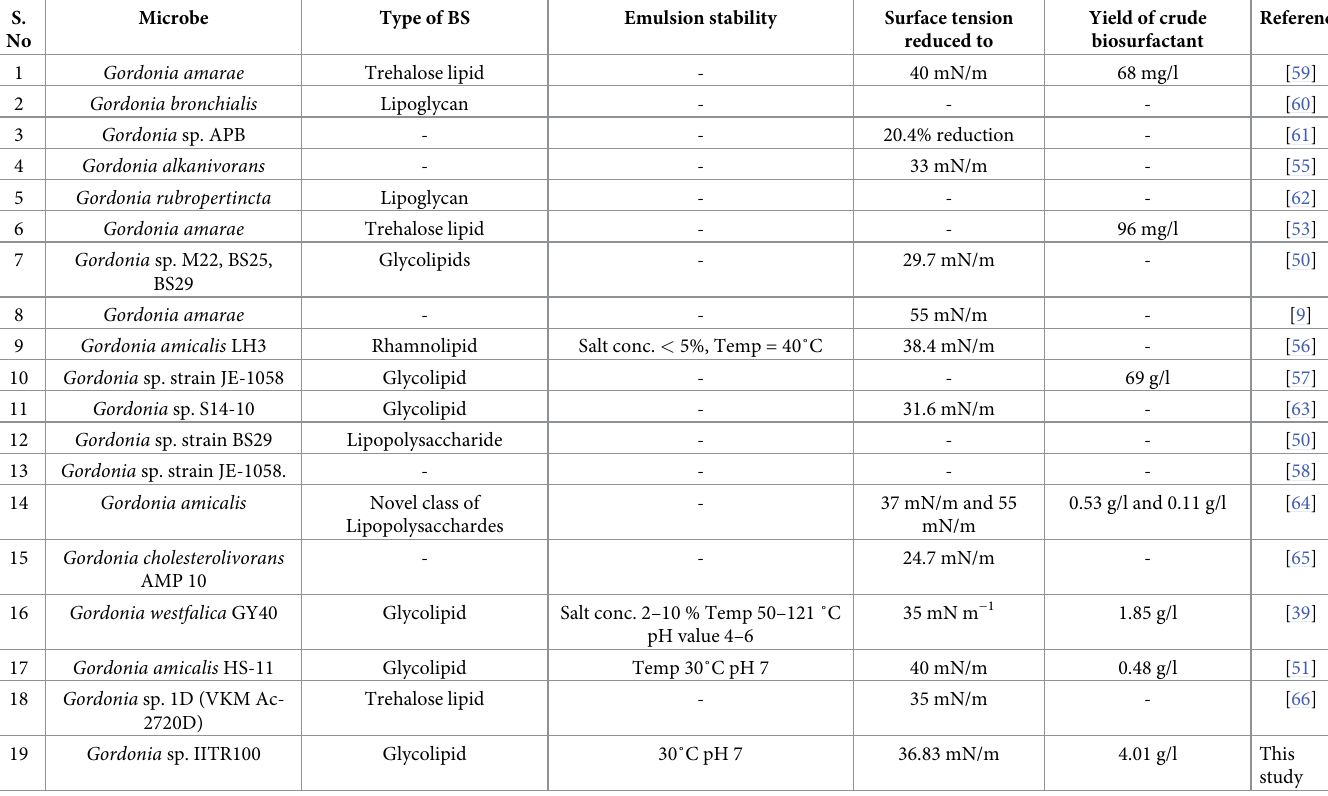
Table 1. Comparison of biosurfactants produced by various strains of Gordonia